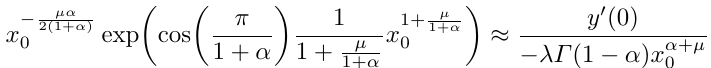
decreasing behaviour is present. That kind of oscillatory asymptotic behaviour is described by equation (3.24). It is very interesting to find the number of oscil- lations and the furthest point in which the last zero occurs. Recently, in [17] a study of fractional oscillations has been published. According to these results, since our equation (1.1) is homogeneous it can admit oscillations with finite number of zeros. The frequency of the oscillations in approximation (3.24) is the same as in [33] (with the time-scale λ